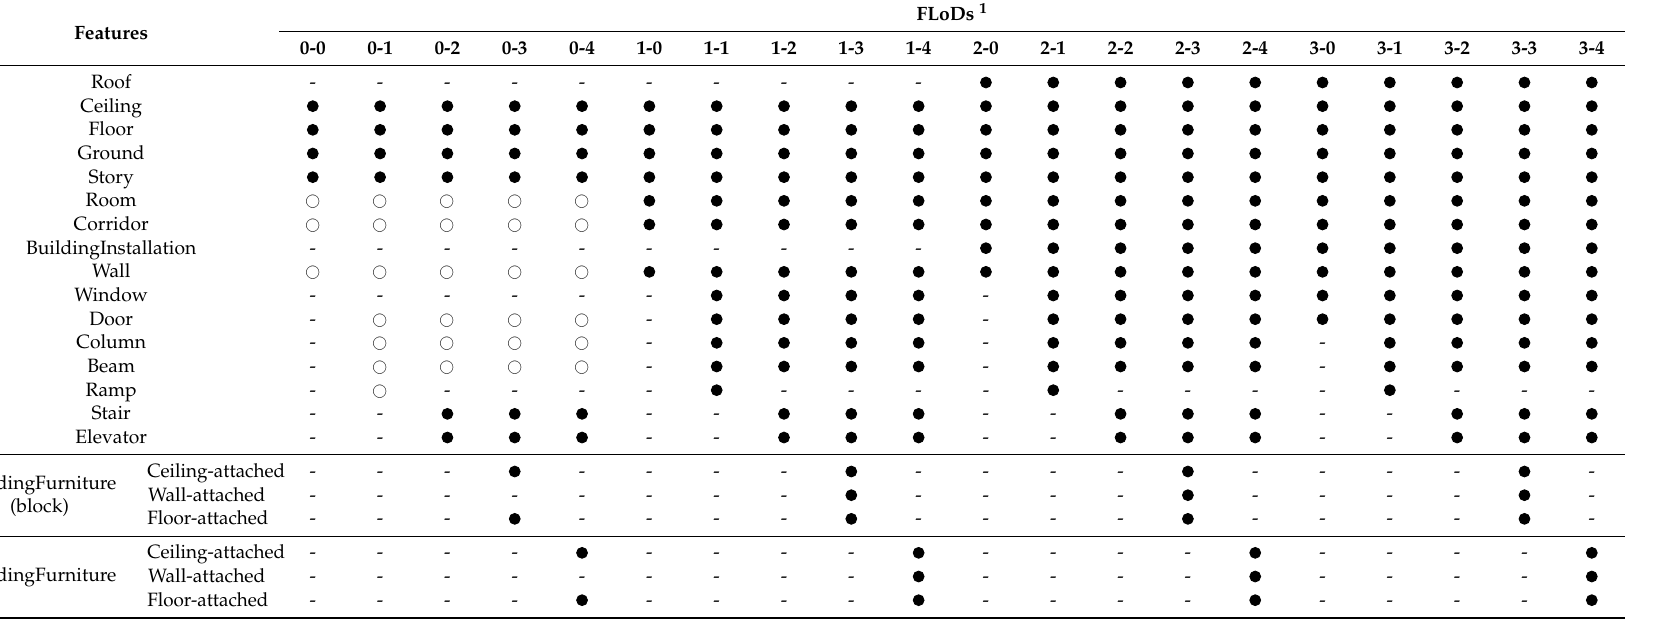
Table 2. Semantic representations for building models in different FLoDs.